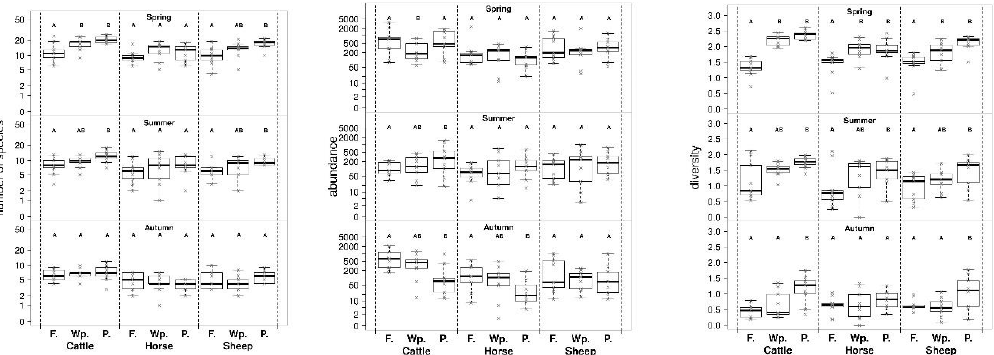
Figure 2. Habitat effect on dung beetle species richness, abundance, and diversity separately for dung type (columns) and seasons (rows). Box plots show medians (thick line), lower, and upper quartiles (boxes), whiskers include the range of distribution without outliers. Different letters above the boxes show the significant differences between habitats within a given season and dung type, applying generalised linear mixed models (GLMMs), linear mixed models (LMMs), and their pairwise comparisons. F.: forest, Wp.: wood pasture, and P.: pasture. For composition of dung beetle assemblages, the seasonal distinction was the most noticeable effect according to the NMDS analysis (Figure 3A, PERMANOVA test: R 2 =